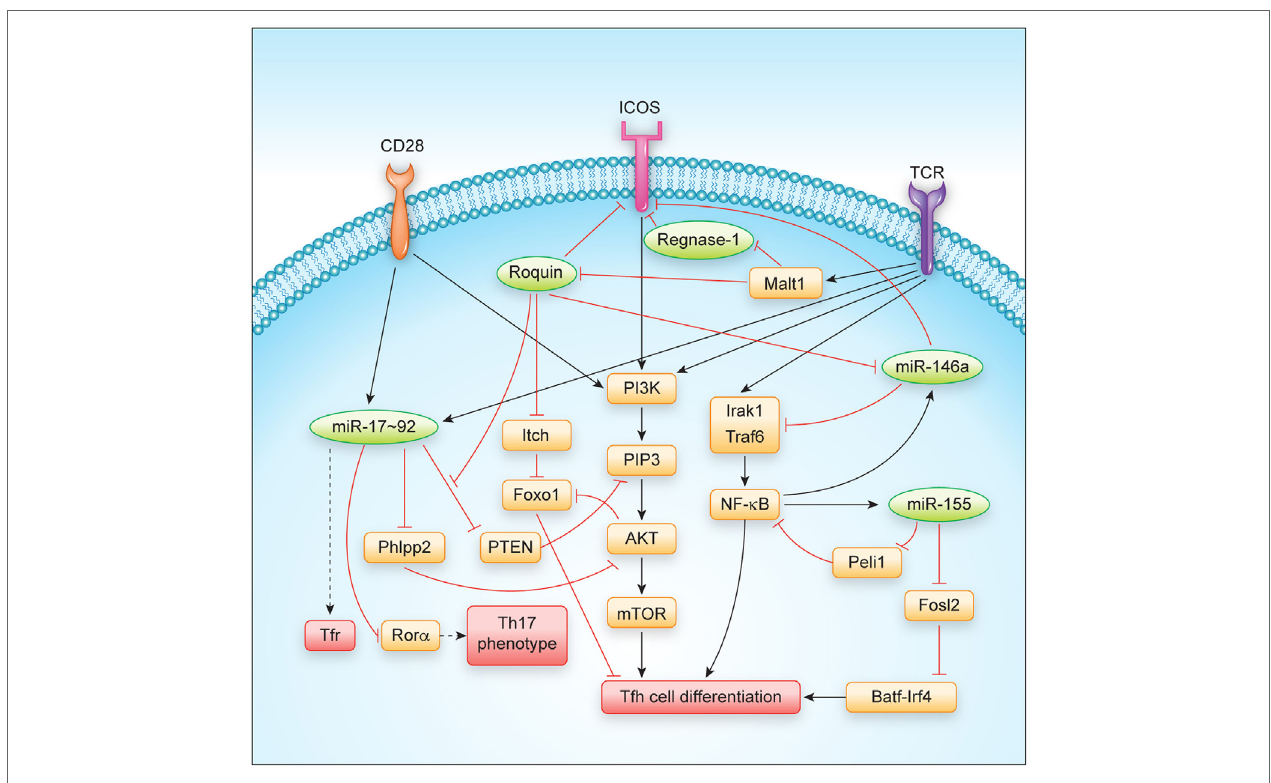
FiGURe 2 | Regulation of T follicular helper cell differentiation and function by major RNA-binding proteins and microRNAs. Abbreviations: TCR, T cell